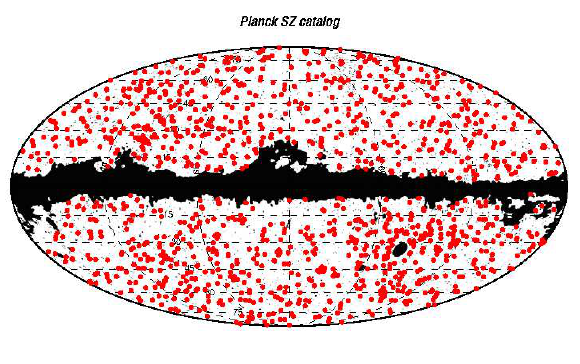
Figure 4: Distribution of the 1227 Planck SZ clus- ters and candidates across the sky, shown in Mollweide projection in Galactic coordinates. The masked re- gions in black color (point-sources, Magellanic clouds and Galactic emission) cover a total area of 16.3%, and are not used by the SZ cluster-finder algorithms. Taken from Planck Collaboration XXIX